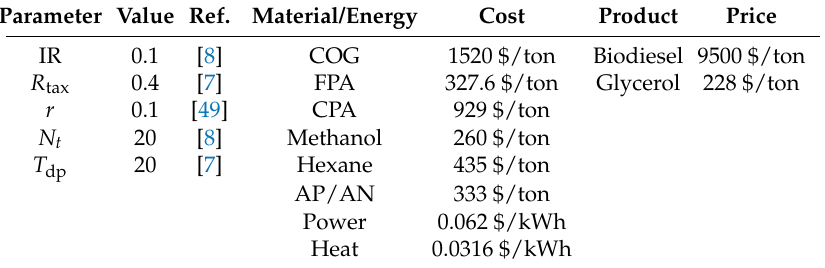
Table 6. Key economic parameters, material costs [7,8], and product selling prices. Ammonium phosphate (AP) and ammonium nitrate (AN) are the nutrients used for cultivation, while coagulant (COG), filtration polymer additive (FPA), and centrifugation polymer additive (CPA) are used for dewatering.